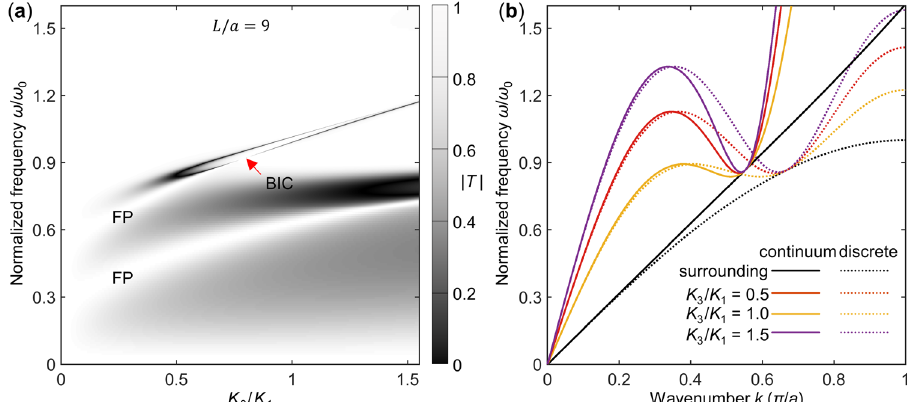
Fig. 6 Phonon transmission results for the phenomenological effective-medium model rather than the discrete mass-and-spring model. a Phonon (cid:3) (cid:4)(cid:3) (cid:4)(cid:3) (cid:4) transmission results. Parameters are L ¼ 9 a and K 3 x ð Þ = K 1 ¼ 1 (cid:2) 1 = 1 þ exp 2 x (cid:2) 3 a = 2 for 0 < x < 3 a . The assumed K 3 x ð Þ ensures that the two surrounding regions exhibit extremely small non-local stiffness parameters (about two orders of magnitude smaller than for the slab). b Dispersion relations for the effective-medium model (solid curves). The dashed curves correspond to the data in Fig. 3b for the discrete mass-and-spring model and can be compared directly to the effective-medium